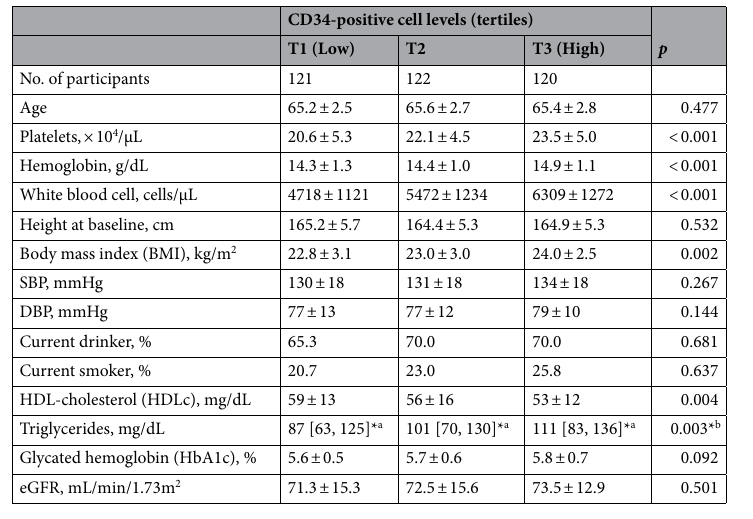
Table 1. Characteristics of study population by circulating CD34-positive cell levels. Values were mean ± standard deviation or n(%). *a: Values were median [first quartile, third quartile]. *b: Logarithmic transformation were performed to evaluate p . SBP: systolic blood pressure. DBP: diastolic blood pressure. eGFR: estimated glomerular filtration rate. CD34-positive cell count tertiles were T1 (Low), < 0.78 cells/μL; T2,